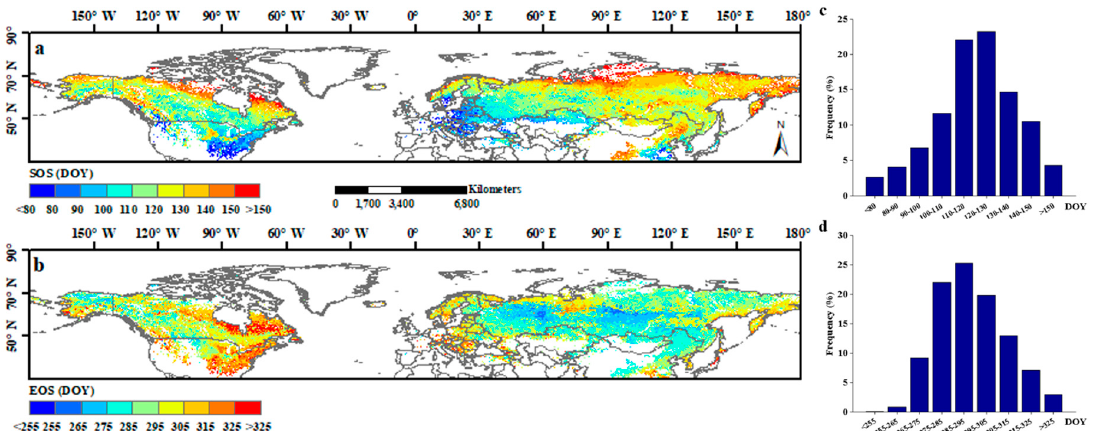
Figure 2. The spatial distribution of average SOS ( a ) and EOS ( b ) of vegetation area in the Northern Hemisphere during 1982–2015. ( c , d ) shows the frequency distribution of 34-year averaged SOS and EOS, respectively.